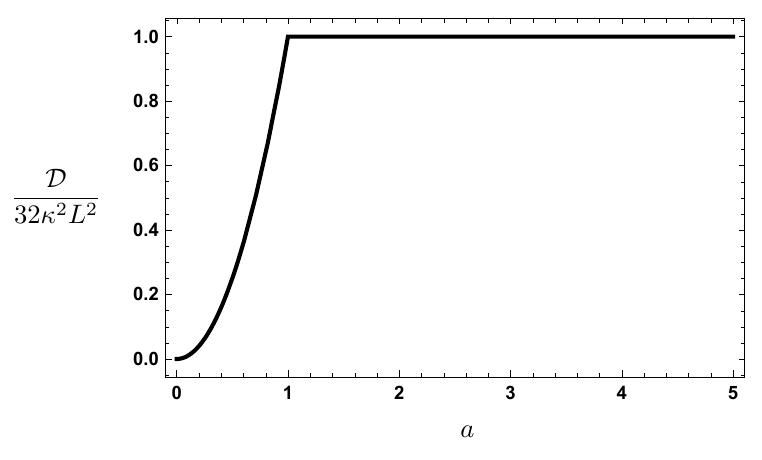
Figure 3 . Dissipation function